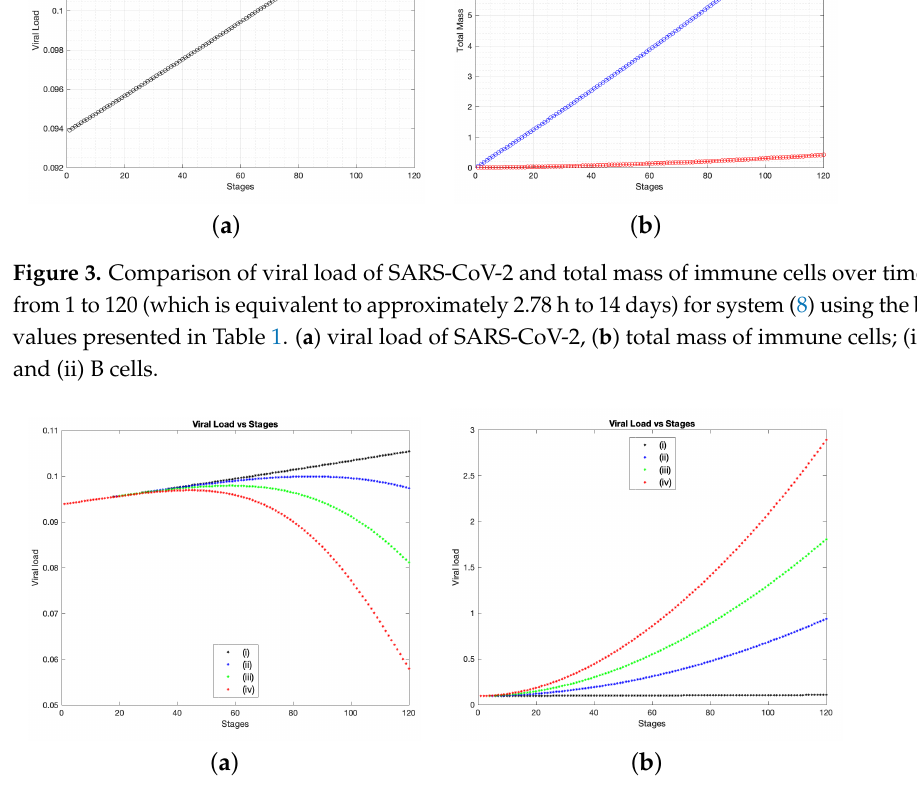
Figure 4. Comparison of viral load of SARS-CoV-2 over time stages from 1 to 120 (which is equivalent to approximately 2.78 h to 14 days) for system (12) using the baseline values presented in Table 1 for multiple scenarios of the percentage variable ( ζ ) . ( a ) when ψ is represented by (10) and ψ : = 1, + − ( b ) when ψ is represented by (10) and ψ : = 1. (i) Baseline case. (ii) ζ : = 100%. (iii) ζ : = 150%. − + (iv) ζ : = 200%.